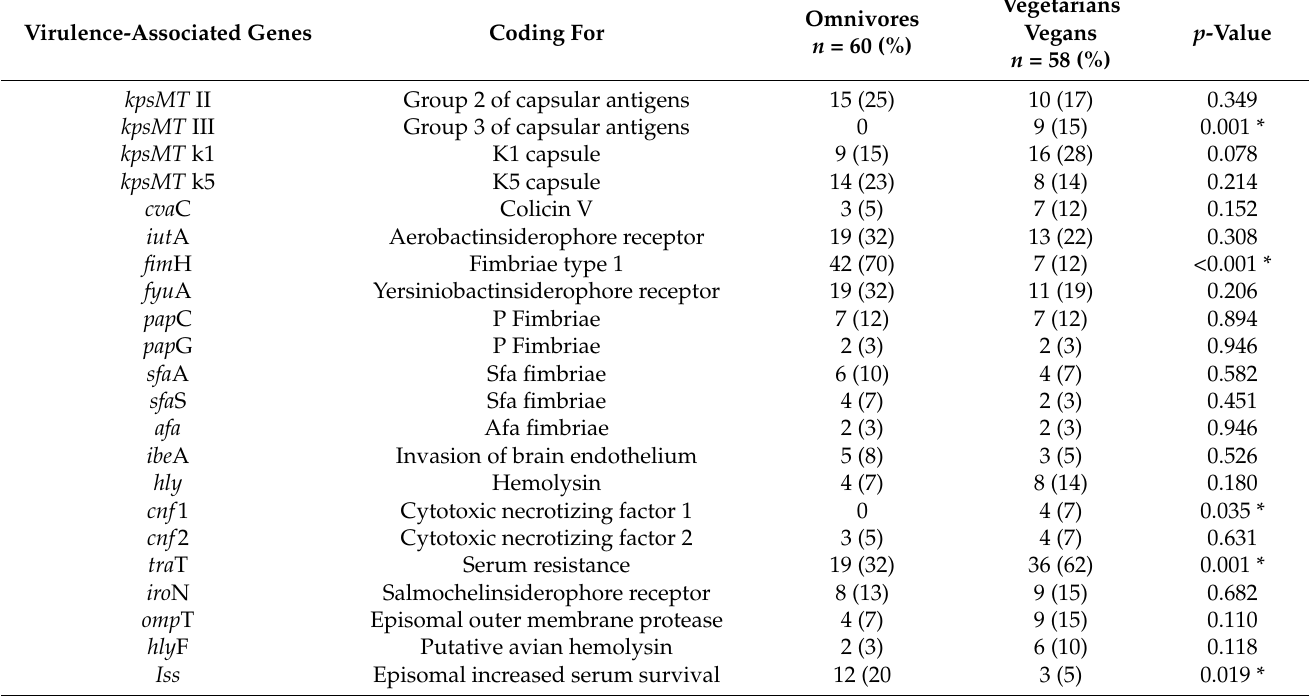
Table 6. Prevalence of VAGs among E. coli isolated from omnivores and vegetarians/vegans.